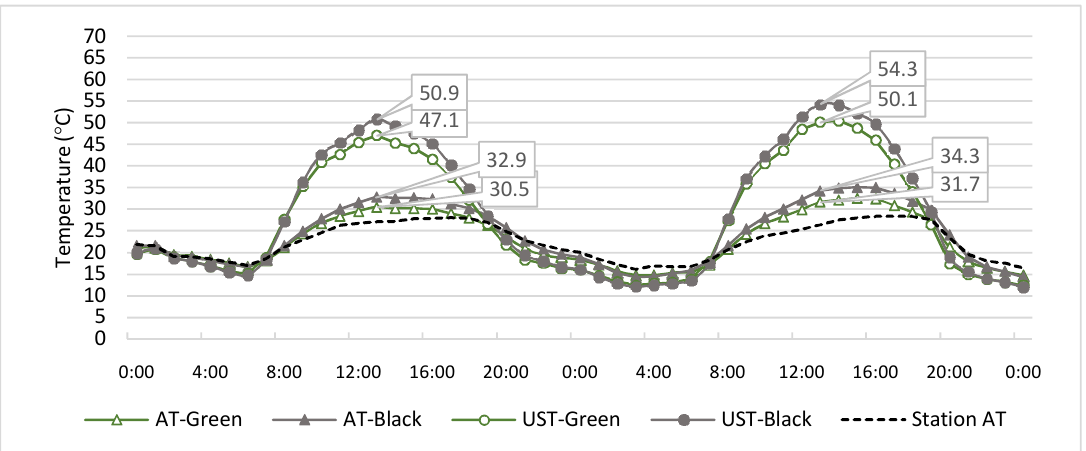
Figure 8. Thermal performance of AT-Green and UST-Green vs. AT-Black and UST-Black (4–5 June).